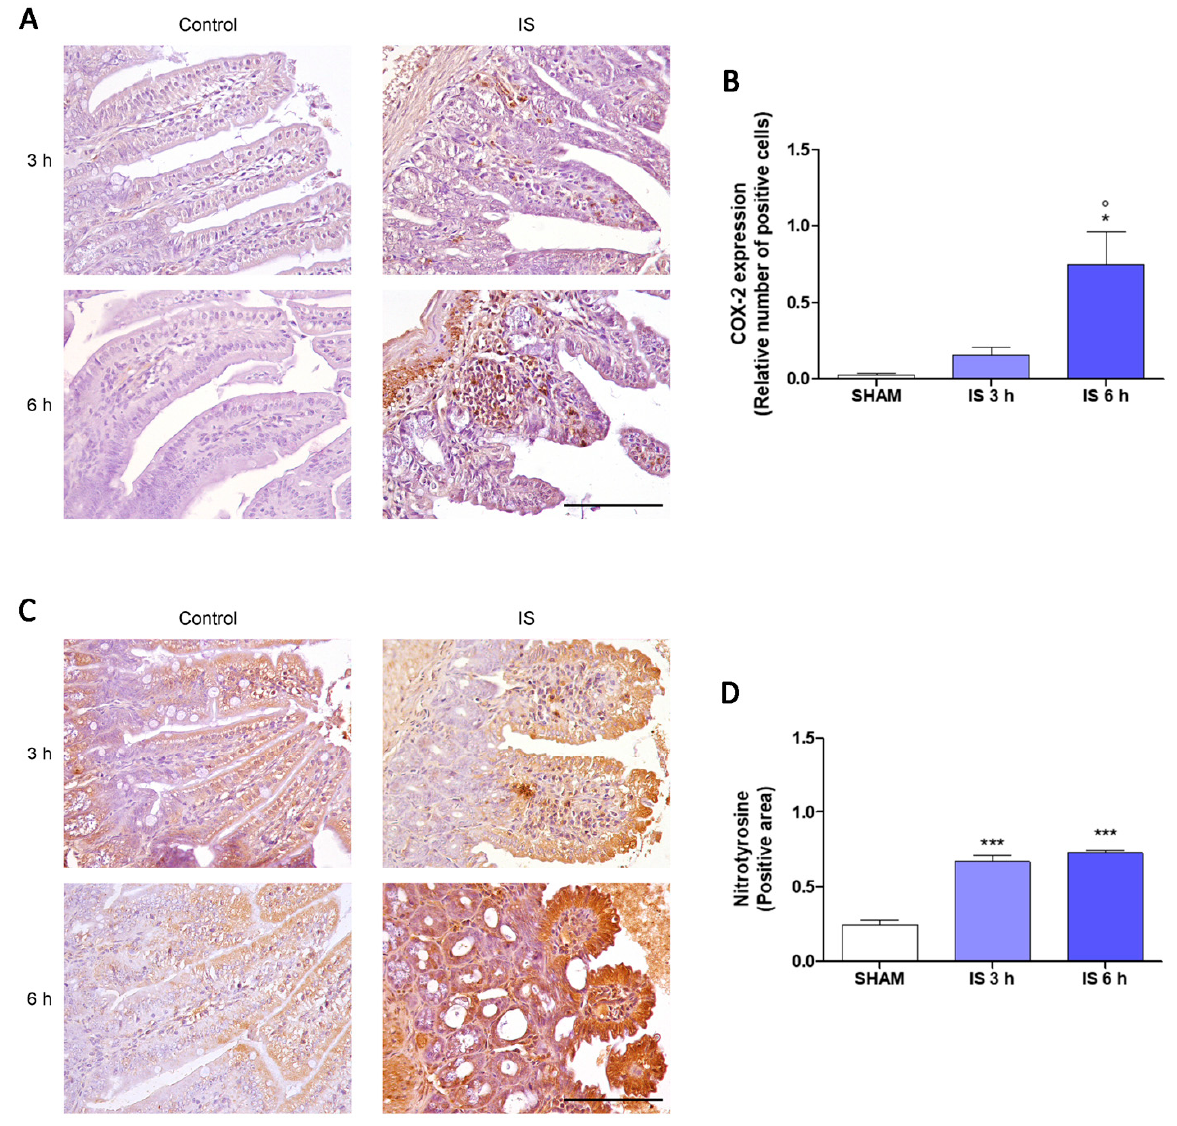
Figure 2. Immunohistochemical localization of COX-2 ( A , B ) and nitrotyrosine ( C , D ) of Indoxyl Sulfate (IS; 800 mg/kg; i.p.)-treated mice, after 3 h and 6 h of treatment (40× magnification, Scale Bar = 100 µm). *** and * denote respectively p < 0.001, and p < 0.05 vs SHAM; ° denote p < 0.05 vs IS 3 h.